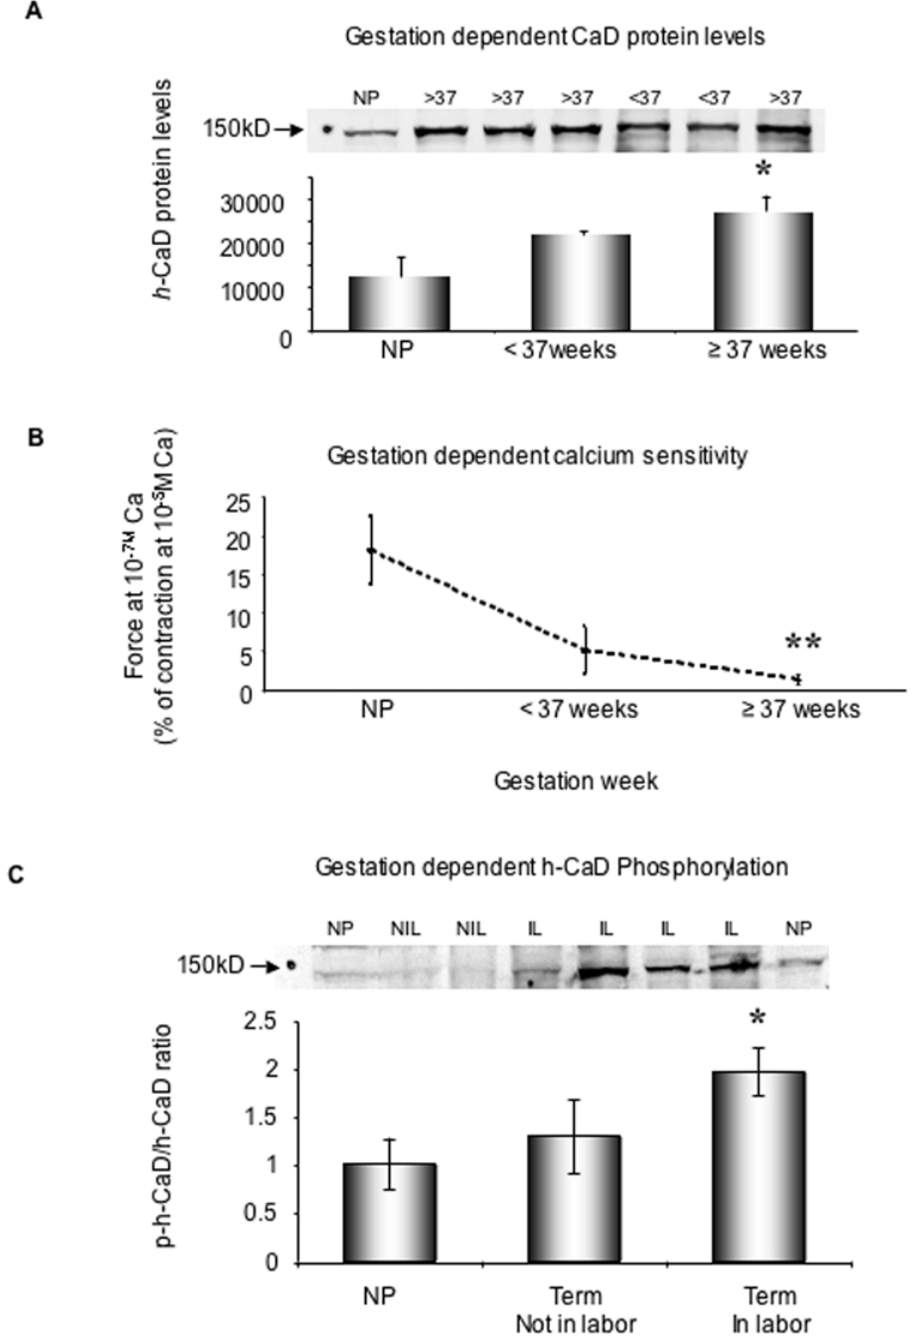
Figure 1. Gestation-dependent changes in CaD content, calcium sensitivity and CaD phosphorylation. A. h- CaD expression increases during pregnancy. n=3–7 samples in each group. * p , 0.05 compared to NP. NP: nonpregnant. A single representative blot is illustrated on the top. To minimize the variation of the signal intensity between different Western blotting experiments, a reference sample was used in each blot for normalization since multiple samples were used from different pregnant women. B. Myometrial calcium sensitivity decreases with gestation. Human nonpregnant and pregnant not in labor uterine strips were permeabilized with alpha-toxin. Contractile force at 10 2 7 M calcium is expressed as a percentage of contraction induced by 10 2 5 M calcium. n=3–5 samples in each group ** p , 0.001 compared to NP. C. Increased CaD phosphorylation at Ser 789 occurs only with the onset of labor. Phosphorylated p- h -CaD is normalized to h- CaD protein level. A single representative blot is included on the top. NP: nonpregnant, NIL: term, not in labor, IL: term, in labor. The samples used in experiments for Fig 1A and Fig 1C are different. Figure 1C is an independent experiment. *p , 0.05 vs. NP. n=5–7 samples in each group.